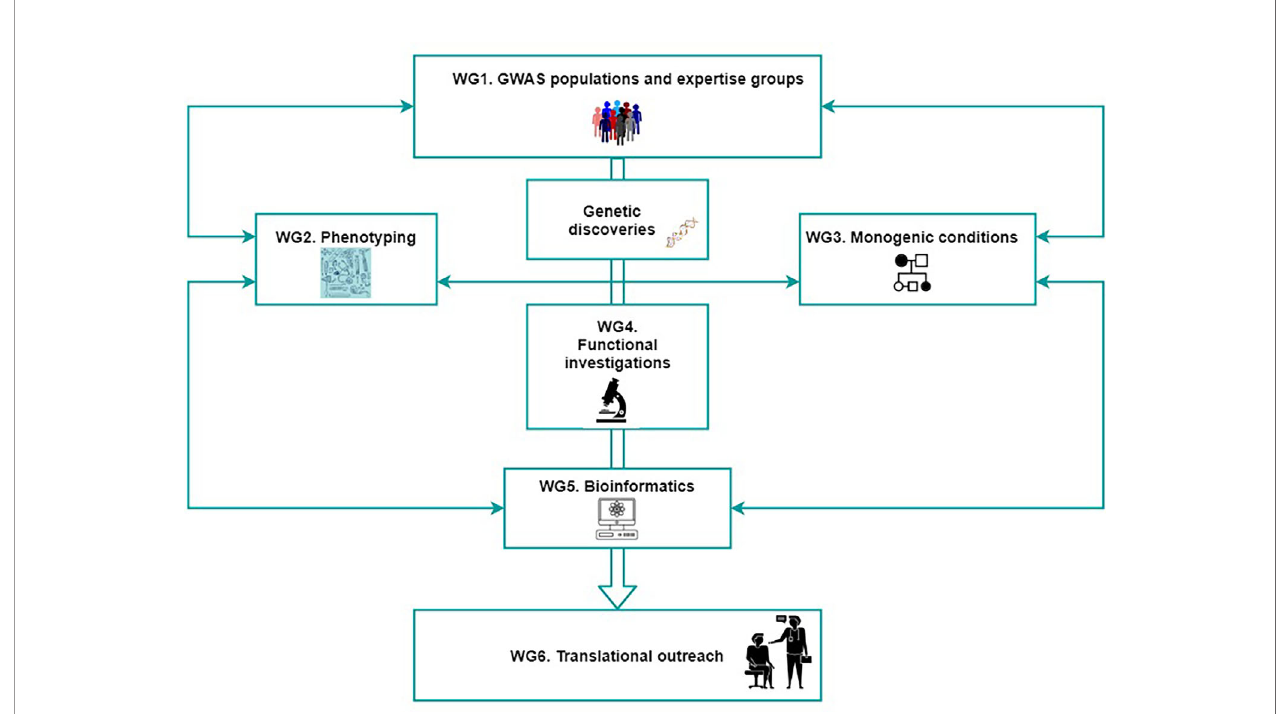
FIGURE 3 | The organization of GEMSTONE across six working groups. Collaboration between researchers working in the genomic, fundamental and clinical fi elds is crucial for successful translational efforts. The fi gure shows the bridging of the different fi elds of science and disciplines of their members (genetic epidemiology, molecular biology, bioinformatics and clinical medicine), into one network that will allow advancing the fi eld of musculoskeletal conditions by using such multidisciplinary approach. WG, working